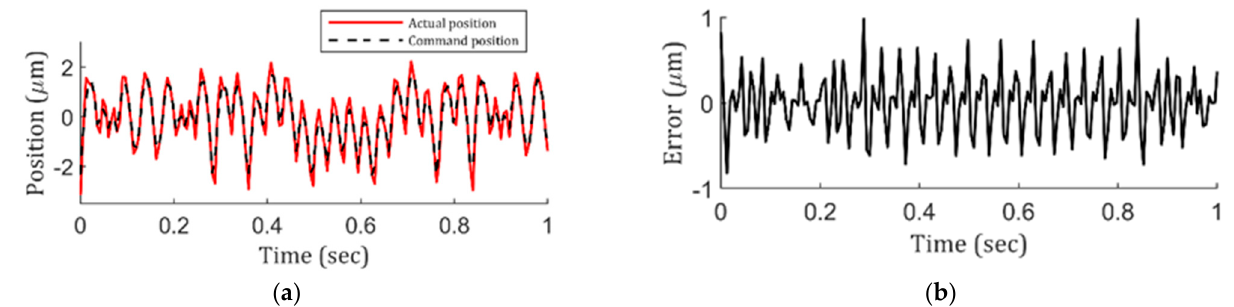
Figure 4. ( a ) Actual vs. command position in the z-axis of the STS with 0.001 s inverse time feed and 0.25° constant-angle cutting condition and corresponding ( b ) position following error.